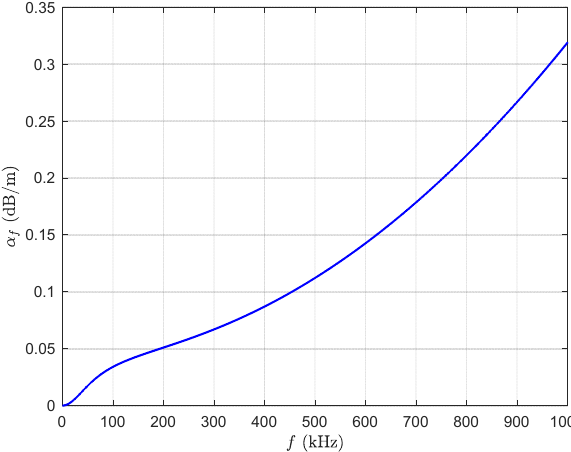
Figure 2. Relationship of the frequency and the absorption coefficient.